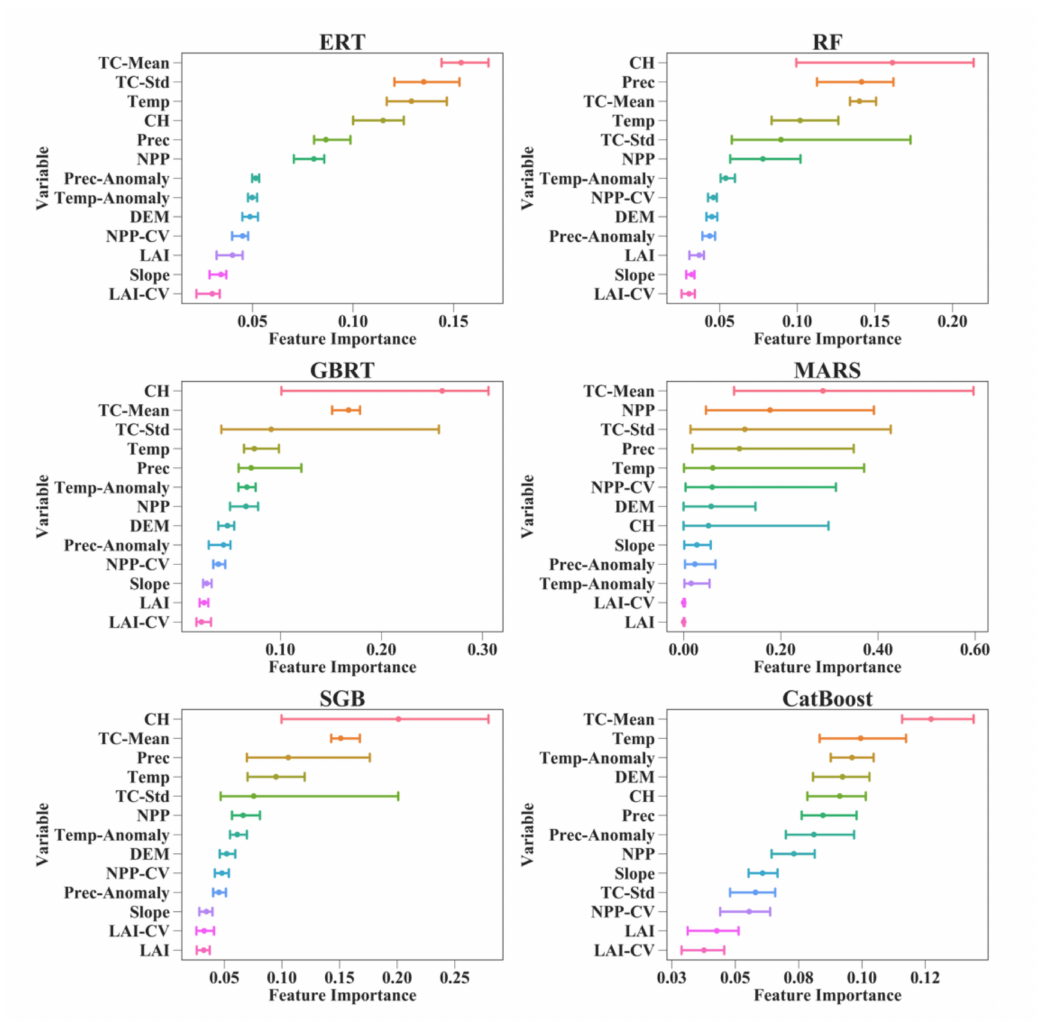
Figure 6. Feature importance values for the predictor variables in eight machine learning regression algorithms under the random sampling scenario. The lines connect the corresponding minimum and maximum feature importance values for 50 runs of each predictor variable, and the points represent the average of the 50 feature importance values for each predictor variable. CH is the canopy height; Prec is the precipitation; Prec-Anomaly is the changes in precipitation; LAI is the leaf area index; LAI-CV is the interannual variation in LAI; NPP is the net primary production; NPP-CV is the interannual variation in NPP; TC-Mean is the mean tree cover within each 0.01 ◦ grid cell; TC-Std is the standard deviation of tree cover within each 0.01 ◦ grid cell; DEM is the digital elevation model; Temp is the temperature; and Temp-Anomaly is the changes in